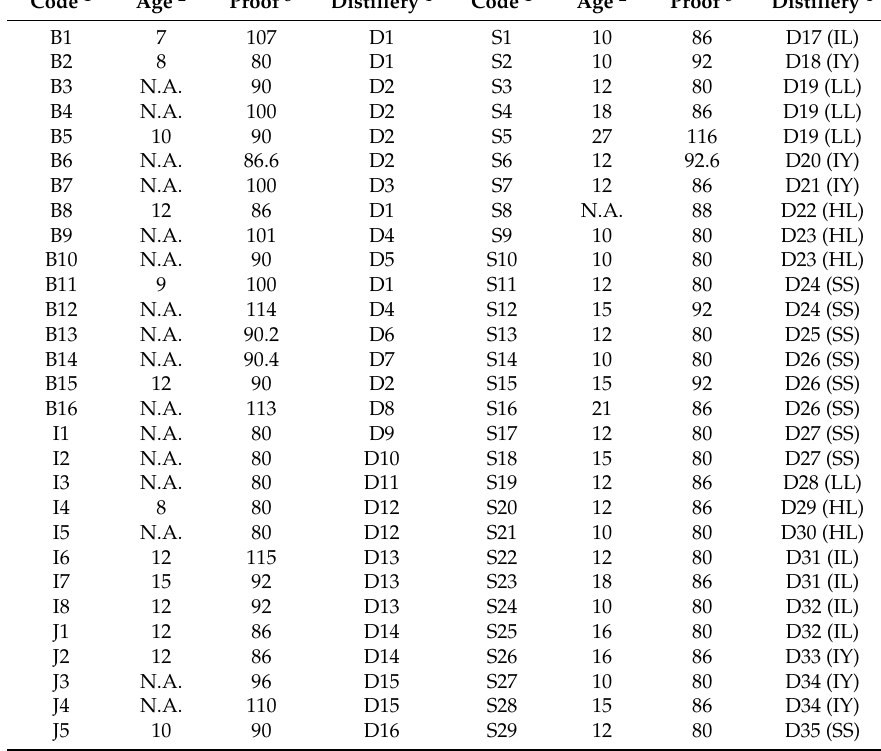
Table 1. List of 68 whisk(e)y samples, including code, age in years (if known), proof, and